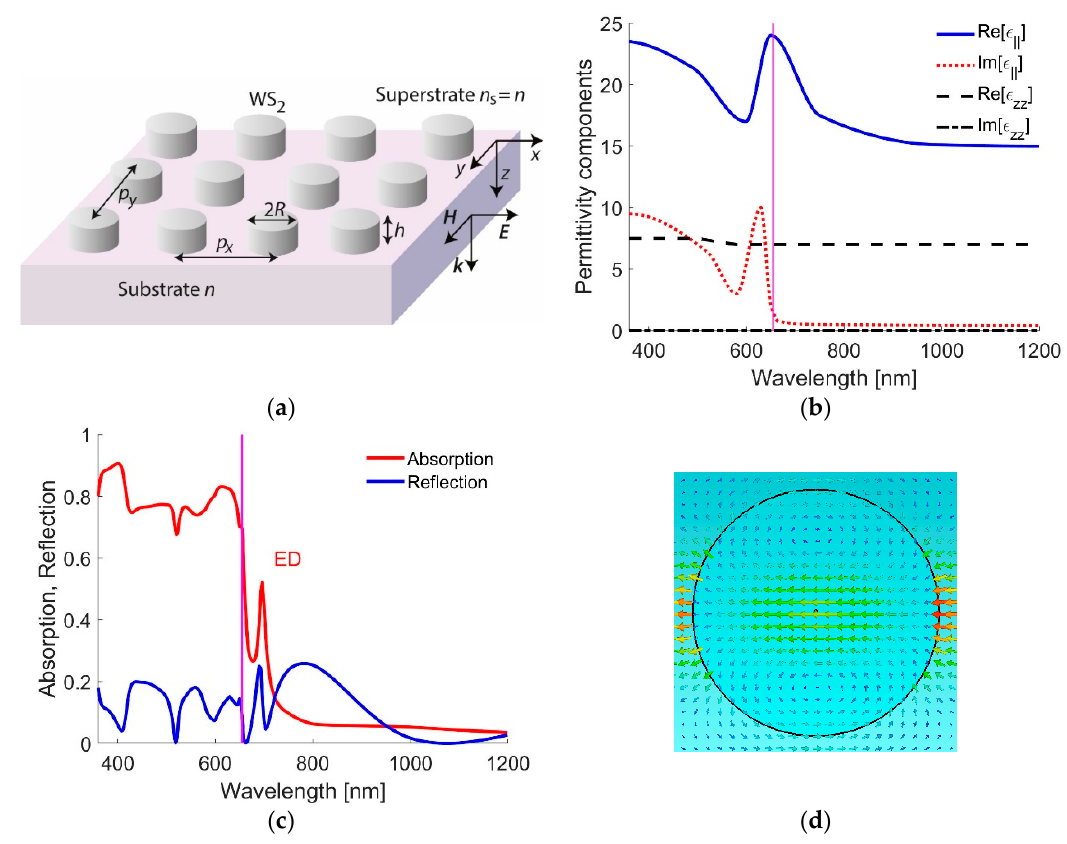
Figure 1. ( a ) Schematic of the transdimensional lattice under consideration. The parameters are the following: nanodisk radius R = 100 nm, height h = 200 nm, and refractive index of surrounding n = n s = 1.5. ( b ) WS 2 permittivity components. ( c ) Absorption and reflection from the nanoparticle array with periods p x = p y = 240 nm. Magenta lines on (b) and (c) panels indicate the wavelength λ c where WS 2 absorption drops significantly, and for λ > λ c , the nanoparticles support Mie and lattice resonances. ( d ) E-field distribution at λ = 697 nm indicating ED contribution of the